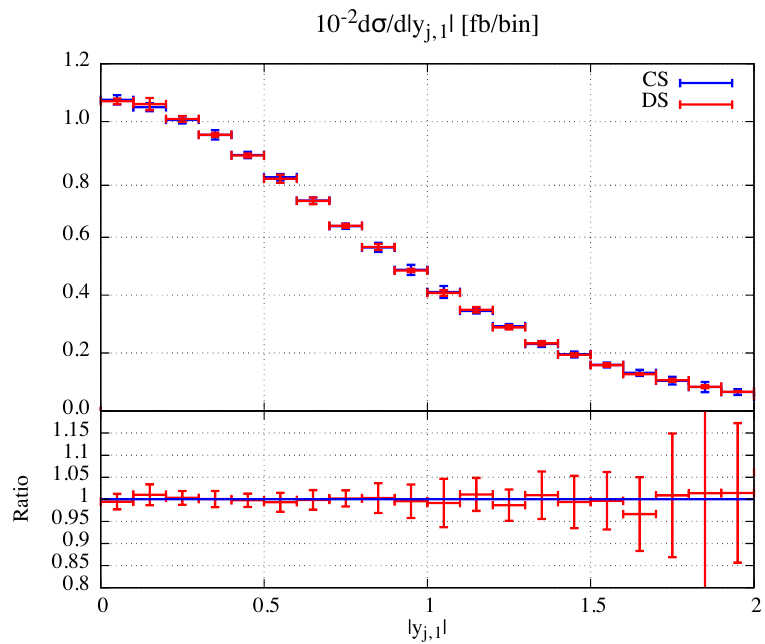
Figure 5. Rapidity distribution of the most energetic jet in γ ∗ → 2 jets at NLO (Durham √ √ algorithm, y = 0 . 1 , s = 125 GeV, α S ( s ) = 0 . 11173799 ). The Dual Subtraction (DS) results cut are shown in red, while the Catani-Seymour (CS) ones in blue. The error bars correspond to the statistical error given by the Monte Carlo